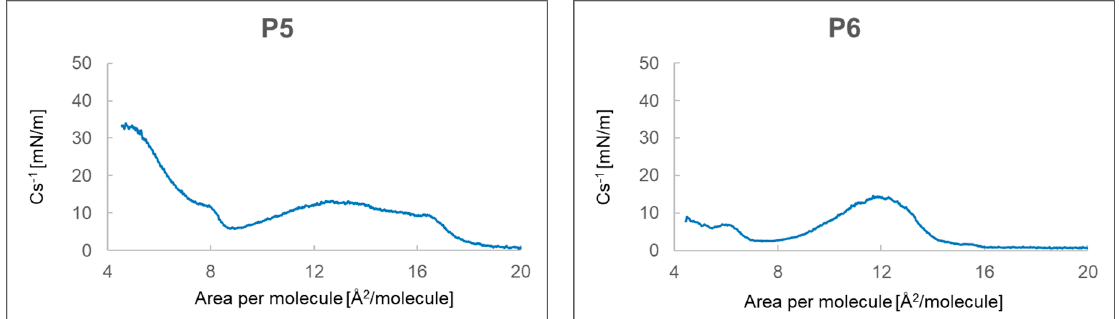
Figure 5. Dependence of the compressibility coefficient depending on the surface area per particle for P2, P4–P6.